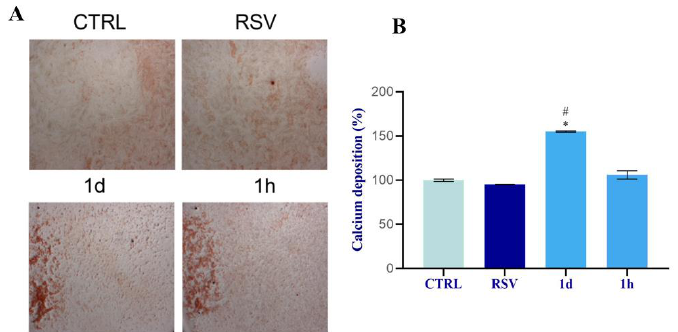
Figure 12. Effects of 1d and 1h (5 µM) on matrix mineralization. ( A ) Microscopic view of the staining at 14 days of treatments. Intensity of mineral nodules was evaluated by Alizarin red staining. Images were taken at magnification of 12× by a stereomicroscope connected with a camera (Leica). ( B ) Quantitative measurement was performed with Cetylpyridinium chloride. Data are expressed as percentages in relation to control cells (In the graph are reported the p values obtained from Tukey test, performed after ANOVA test: * Significance respect to CTRL, * p < 0.001; # significance with respect to RSV, # p < 0.001).